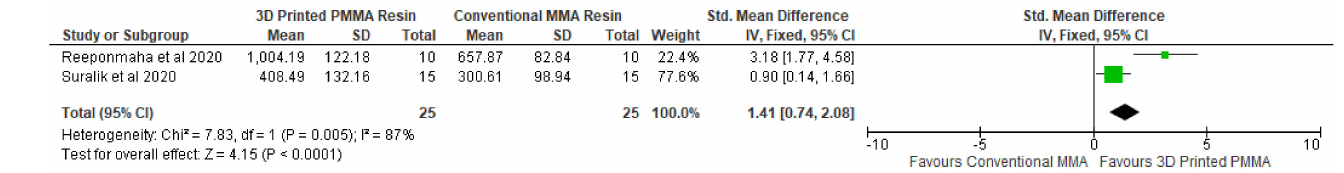
Figure 6. Forest plot comparing fracture strength between 3D-printed PMMA resin and conventional PMMA resin.